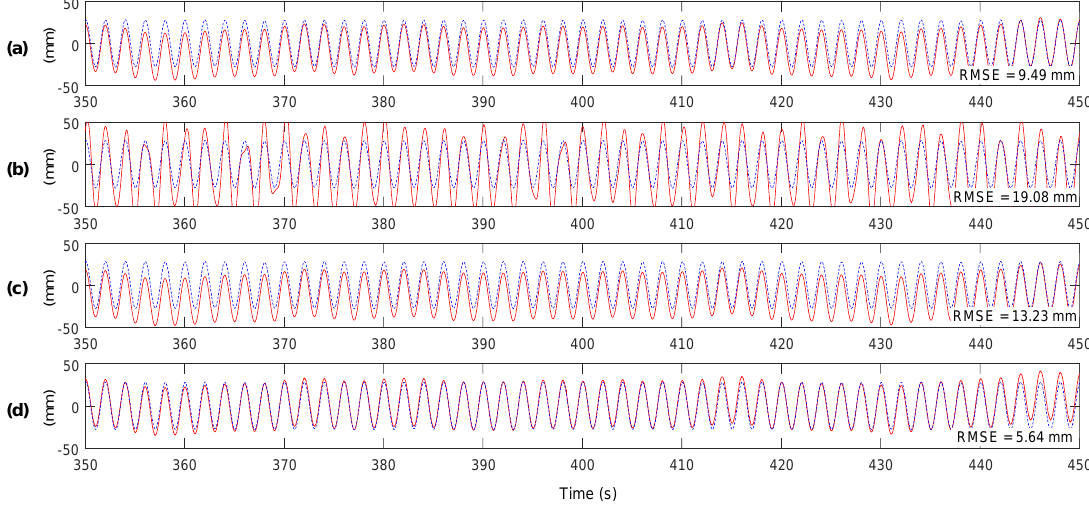
Figure 9. Displacement estimation results and RMSE errors for the method of ( a ) Smyth and Wu [23], ( b ) tightly-coupled and ( c ) loosely-coupled Kalman filter [22], and ( d ) the proposed method.